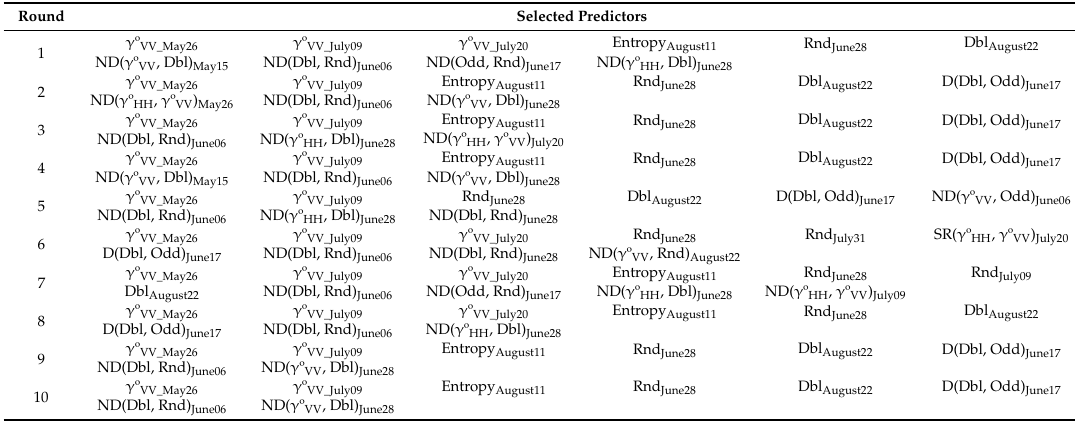
Table 4. Selected predictors based on linear discriminant analysis